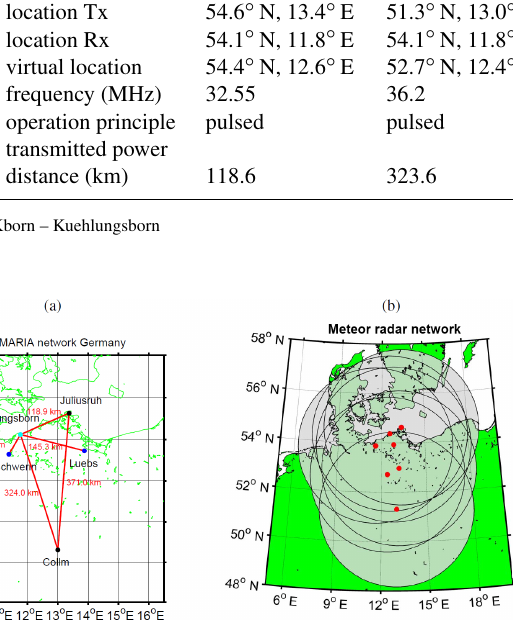
Table 2. Technical specification of the multi-static links used in the experiment campaign in March 2016. Parameter